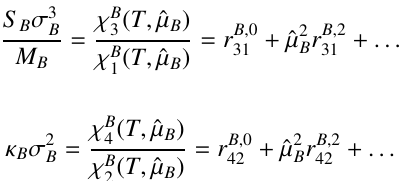
Figure 1: Results for χ B temperature, obtained from the single-temperature analysis (see text). We plot χ B out that its determination is guided by a prior, which is linked to χ B corresponds to the toy model introduced in [23,